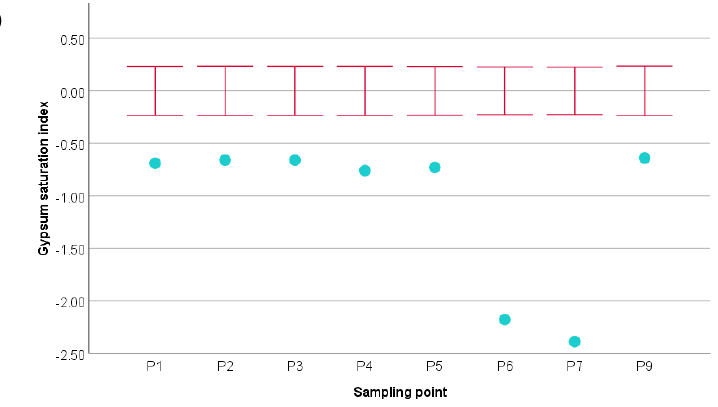
Saturation index for chosen mineral-phase: ( a ) calcite, ( b ) dolomite, ( c ) gypsum. Explanation: blue points—undersaturated solution, red points—supersaturated solution, red whiskers—equilibrium state.